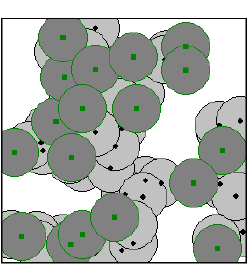
8 of 13 Algorithm 1. Pseudocode for the moving distance reduction scheme. /* P i 0 ( x i 0 , y i 0 ) and P i 1 ( x i 1 , y i 1 ) are the initial position and the candidate target position of the i th mobile sensor s i , i = 1, …, m . */ 1.